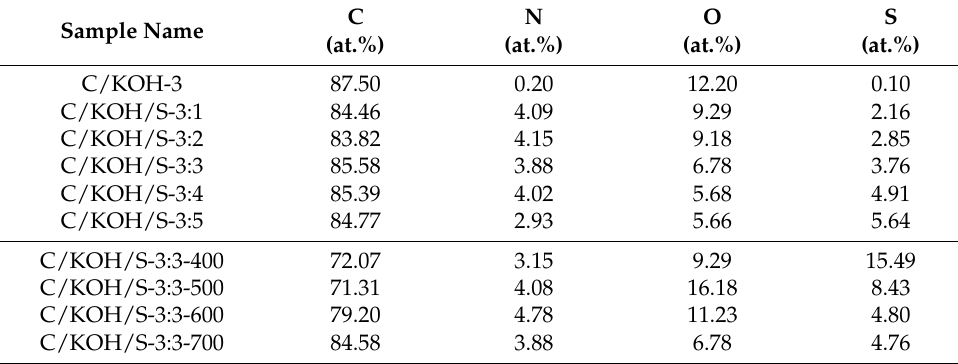
Table 3. Atomic composition analysis of the as-obtained AC